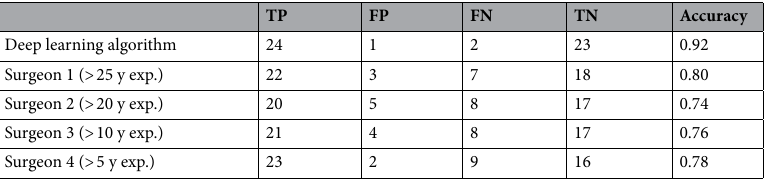
Table 3. Diagnostic accuracy of the deep learning algorithm and four spine surgeons (n = 50). TP, true positive; FP, false positive; FN, false negative; TN, true negative; y, years; exp, experience.